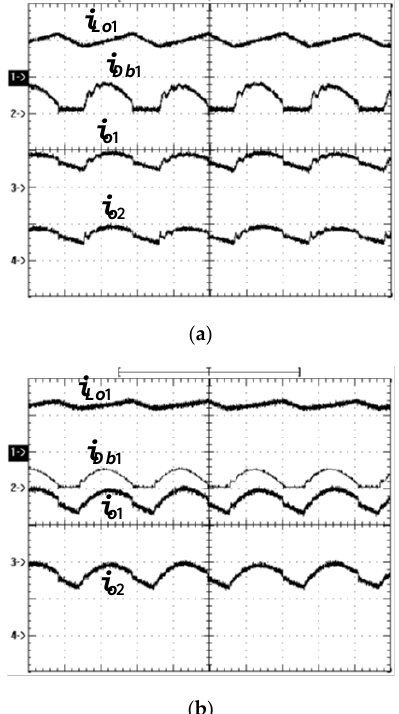
Figure 11. Measured waveforms of the secondary-side currents i Lo1 , i Db1 , i o1 and i o2 ( a ) 20% load (i Lo1 , i Db1 : 5 A / div; i o1 , i o2 : 10 A / div; time: 4 µ s / div) and ( b ) full load (i Lo1 , i Db1 , i o1 , i o2 : 20 A / div; time: 4 µ s /